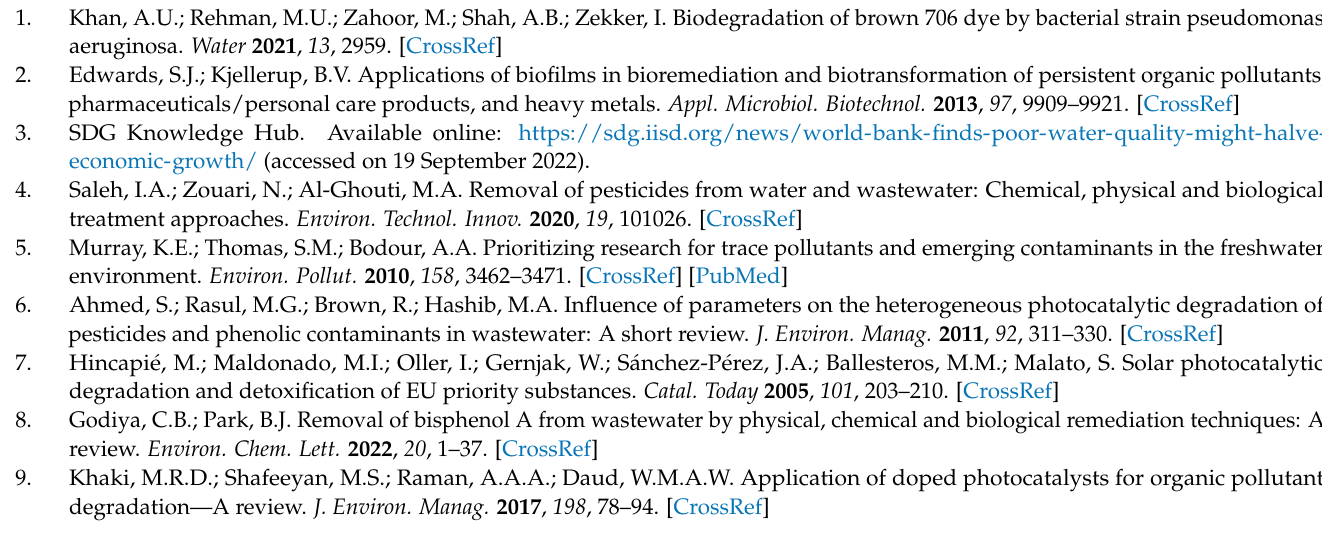
and 19ZrO 2 /Fe 3 O 4 ; Figure S3: Raman spectra of particles: Fe 3 O 4 and ZrO 2 , as well as synthesized nanopowders: 0.9ZrO 2 /Fe 3 O 4 ; 3.5ZrO 2 /Fe 3 O 4 ; 12ZrO 2 /Fe 3 O 4 and 19ZrO 2 /Fe 3 O 4 ; Figure S4; Esti- mation of particles Fe 3 O 4 and synthesized ZrO 2 /Fe 3 O 4 catalysts optical band energy by [ F ( R ) · h ν ] 1/2 vs. photon energy (h ν ) plotting; Figure S5: Kinetics of removal of sulcotrione (0.05 mmol/dm 3 ) at pH 2.8 in the presence of 3.5ZrO 2 /Fe 3 O 4 , 12ZrO 2 /Fe 3 O 4 , and 19ZrO 2 /Fe 3 O 4 (1.0 mg/cm 3 ) with 3.0 mmol/dm 3 H 2 O 2 , under SSI; Figure S6: Influence of stirring prior to irradiation on the removal of sulcotrione (0.05 mmol/dm 3 ) with Fe 3 O 4 and various ZrO 2 /Fe 3 O 4 nanopowders (1.0 mg/cm 3 ) in the presence of H 2 O 2 (3.0 mmol/dm 3 ) at pH 2.8, using SSI; Figure S7: Effect of stirring/sonication on the removal efficiency of fluroxypyr (0.05 mmol/dm 3 ) in the presence of 45 mmol/dm 3 H 2 O 2 and 1.0 mg/cm 3 19ZrO 2 /Fe 3 O 4 at pH 2.8 using solar irradiation; Figure S8: Effect of the initial concentration of H 2 O 2 on the removal efficiency of fluroxypyr (0.05 mmol/dm 3 ) in the presence of 1 mg/cm 3 19ZrO 2 /Fe 3 O 4 at pH 2.8 using solar irradiation; Figure S9: Kinetics of photolytic and photocatalytic degradation of amitriptyline (0.05 mmol/dm 3 ) in the presence of 12ZrO 2 /Fe 3 O 4 as a photocatalyst (1.0 mg/cm 3 ) and using solar irradiation under different experimental conditions; Figure S10: Kinetics of photocatalytic degradation of amitriptyline (0.05 mmol/dm 3 ) in the presence of 19ZrO 2 /Fe 3 O 4 (1.0 mg/cm 3 ) as a photocatalyst, H 2 O 2 (3.0 and 45 mmol/dm 3 ), at pH 2.8